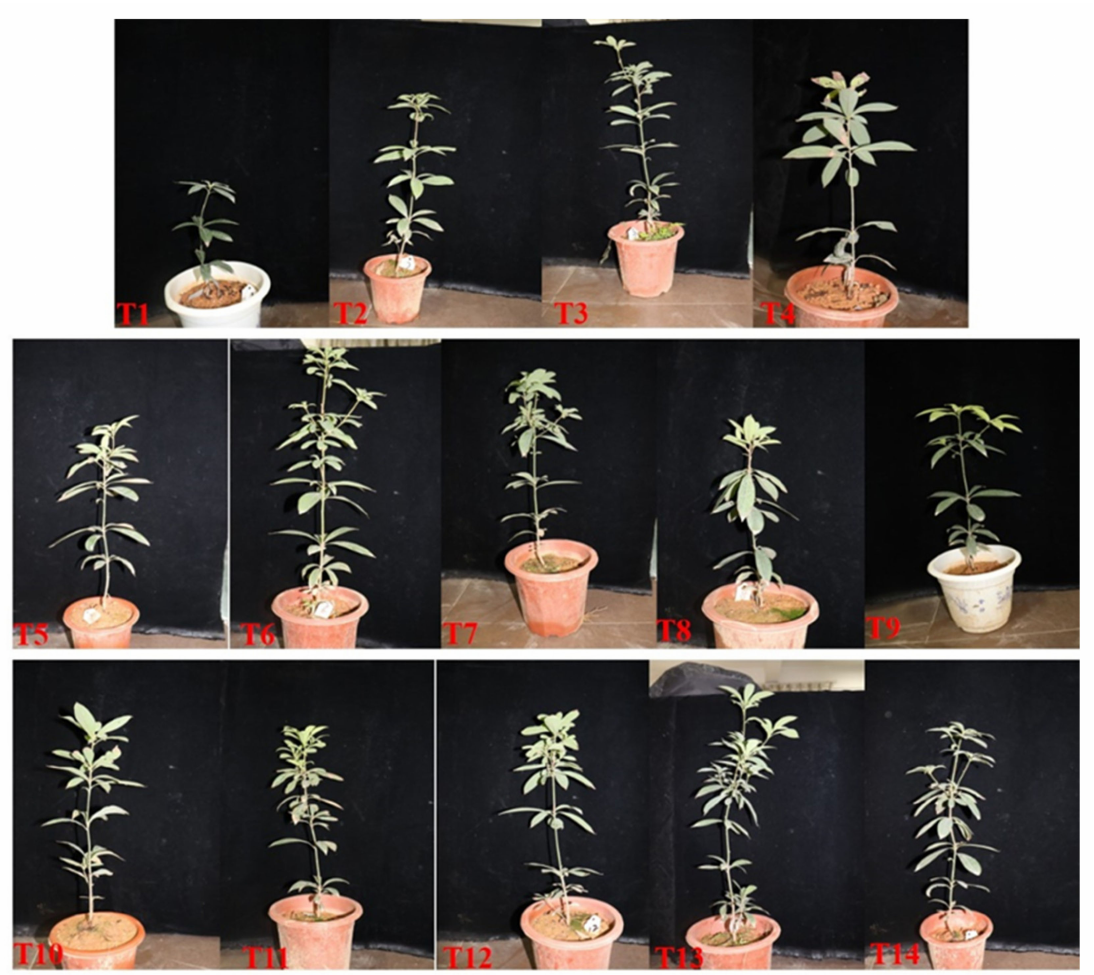
Figure 1. P. bournei seedlings growth under different N-P-K fertilization